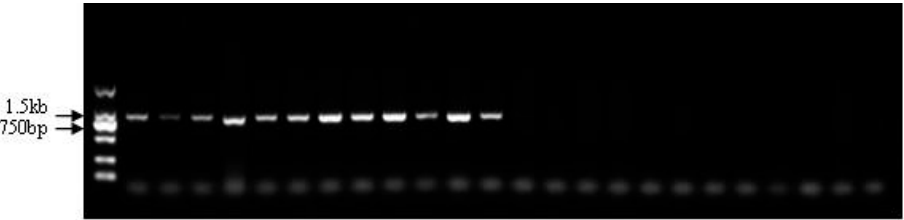
Figure 4. Detection of sex-specific marker ps3137s2 in male and female Pelodiscus sinensis populations.